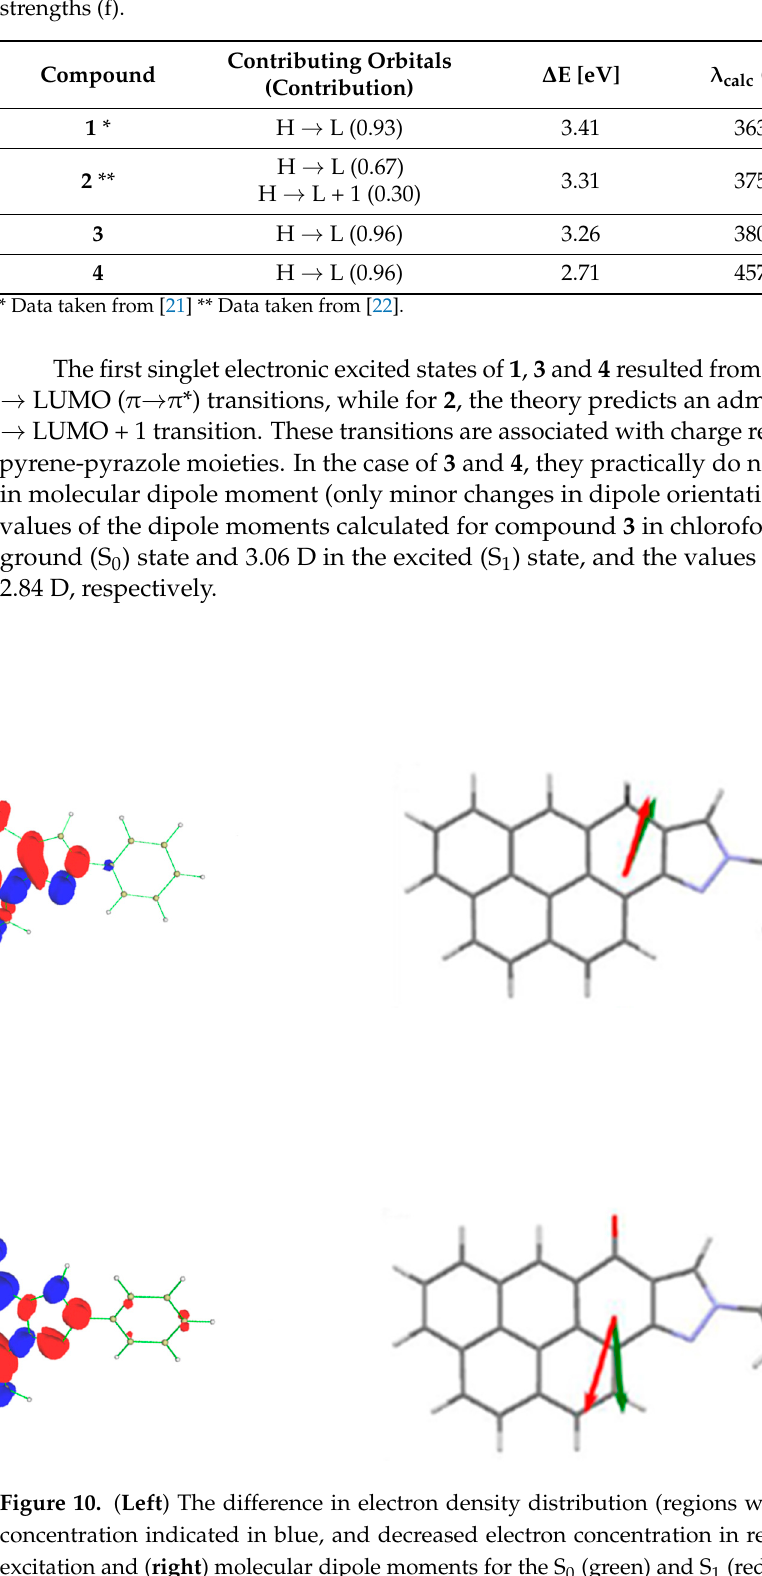
Table 2. TD-DFT calculated electronic transitions involved in the formation of lowest-energy singlet excited states (S 0 → S 1 ) of compounds 1–4 in chloroform, their energies, wavelengths and oscillator strengths (f).